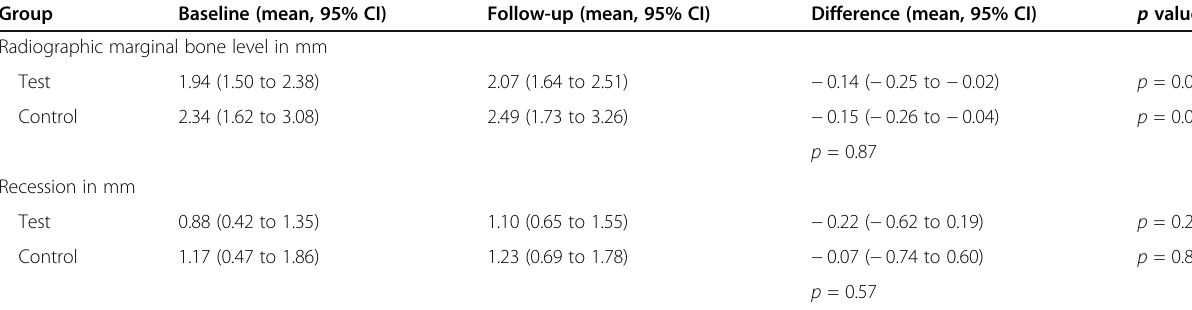
Table 3 Radiographic marginal bone level and clinical recession on neighbouring tooth surface